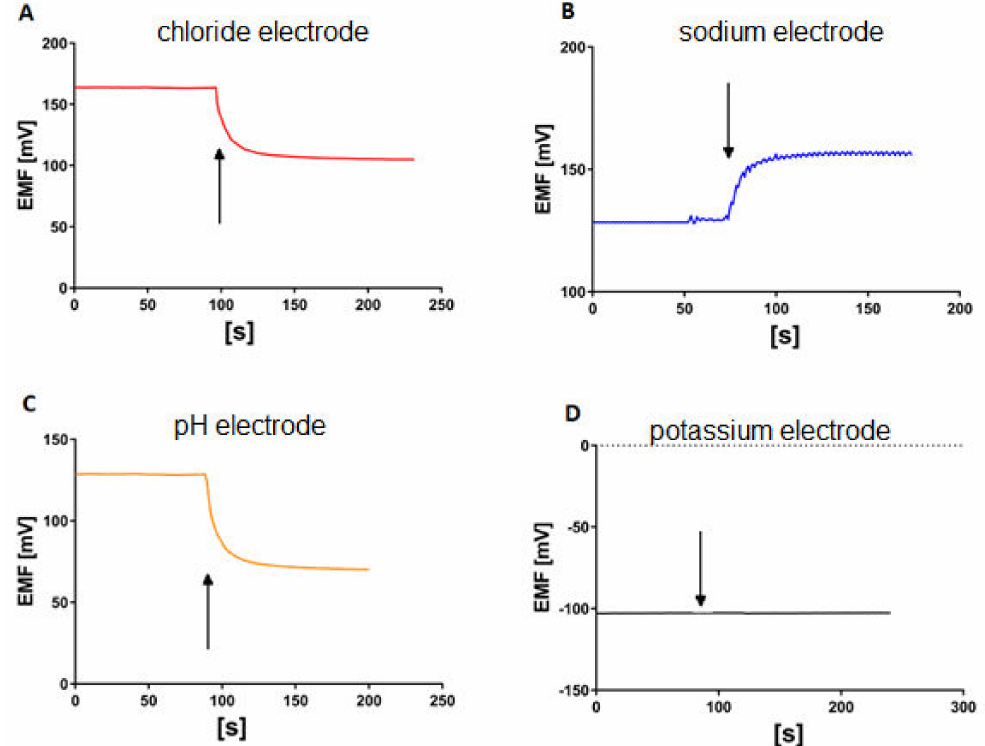
Figure 2. Kinetics of the ion selective electrodes response after changing the medium. The start of medium exchange is shown by the arrow. ( A ) KHS3 solution is replaced by KHS1, ( B ) KHS2 solution is replaced by KHS1, ( C ) KHS1 solution equilibrated to pH = 6.4 is replaced by KHS1 (pH = 7.4), ( D ) KHS3 solution is replaced by KHS1 (no change in potassium